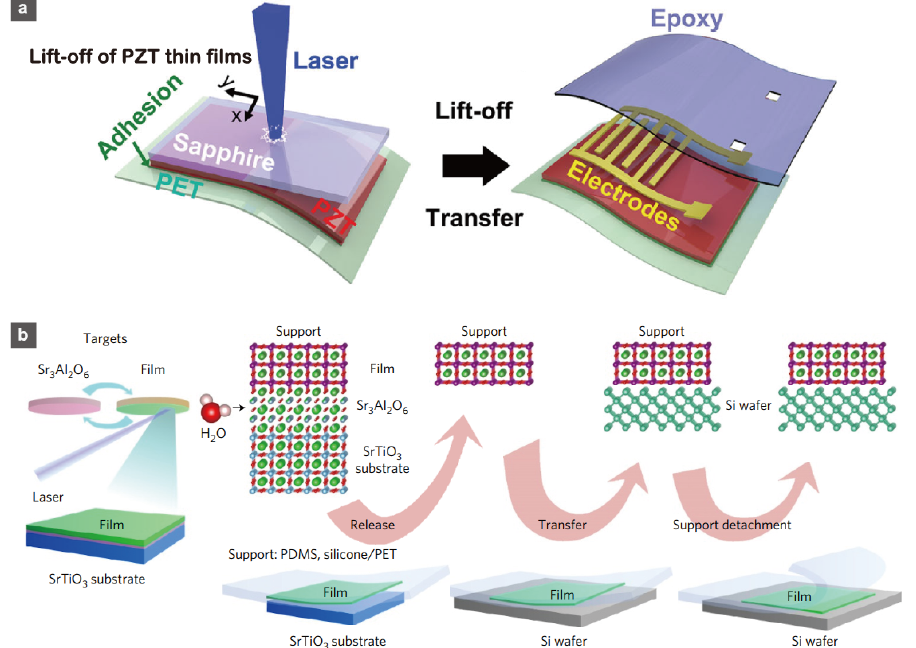
Figure 16. Schematics of the fabrication process for ( a ) a flexible, large-area PZT film by the laser lift-off method and ( b ) a flexible, large-area, epitaxial perovskite film by the etching of a sacrificial water-soluble layer method. Reprinted with permission from Refs. [142,172]. Copyright 2014 John Wiley and Sons and Copyright 2016 Springer Nature.